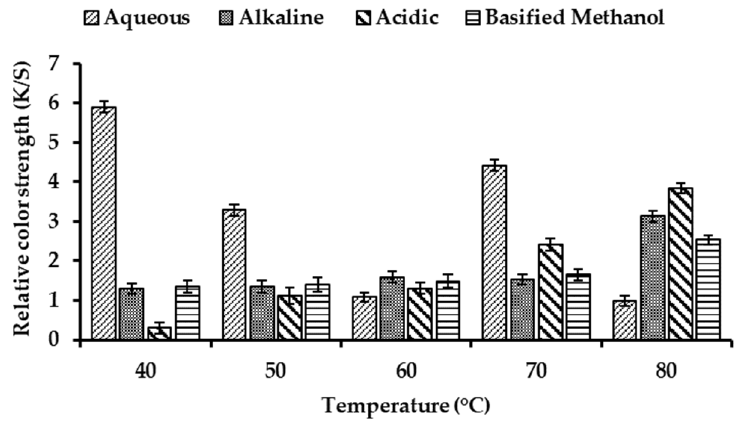
Figure 5. Dyeing of wool with rose extract at various temperatures.